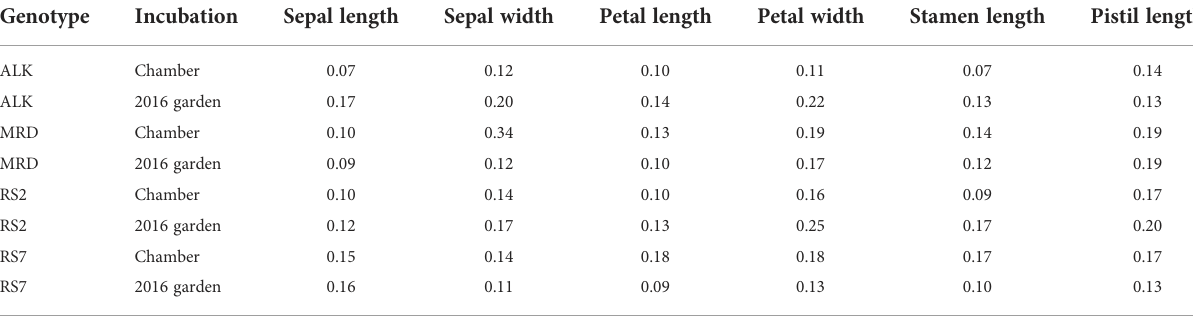
TABLE 4 CV values of each fl ower